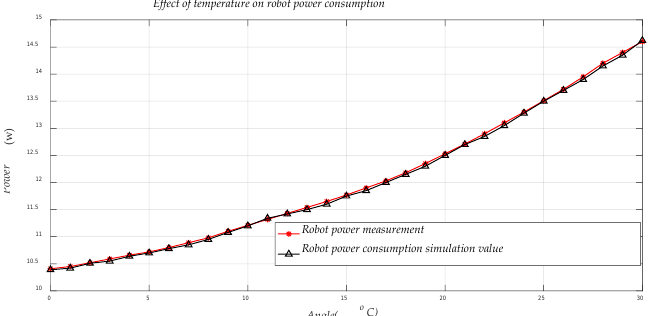
Figure 10. Influence of temperature on the power consumption of robot motion system.